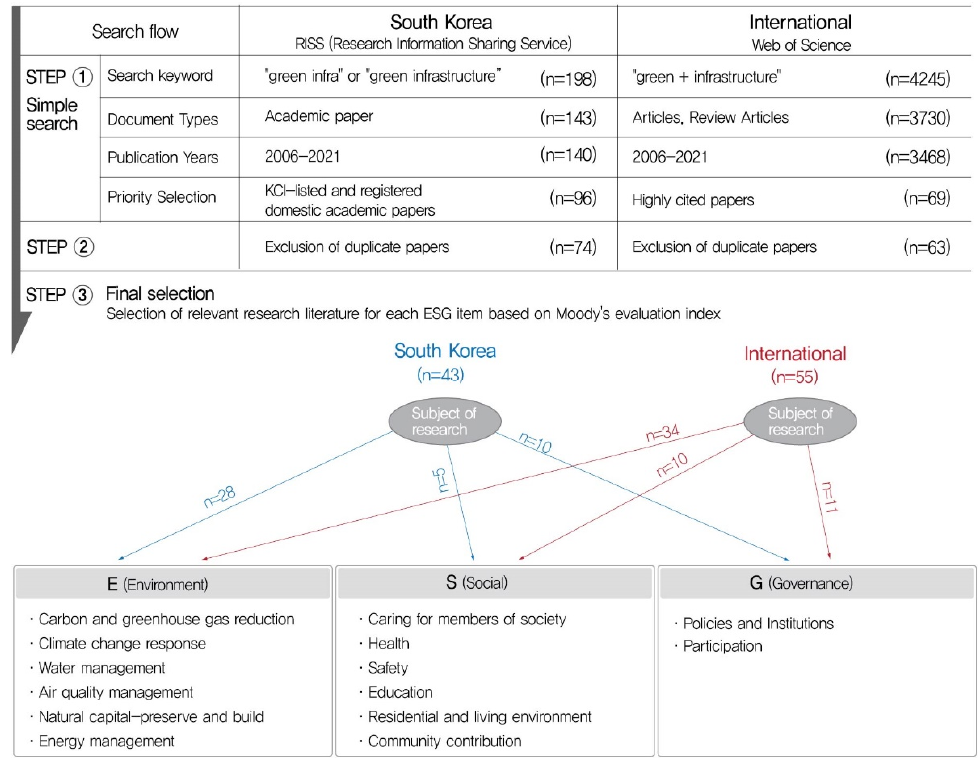
Figure 1. Research process.